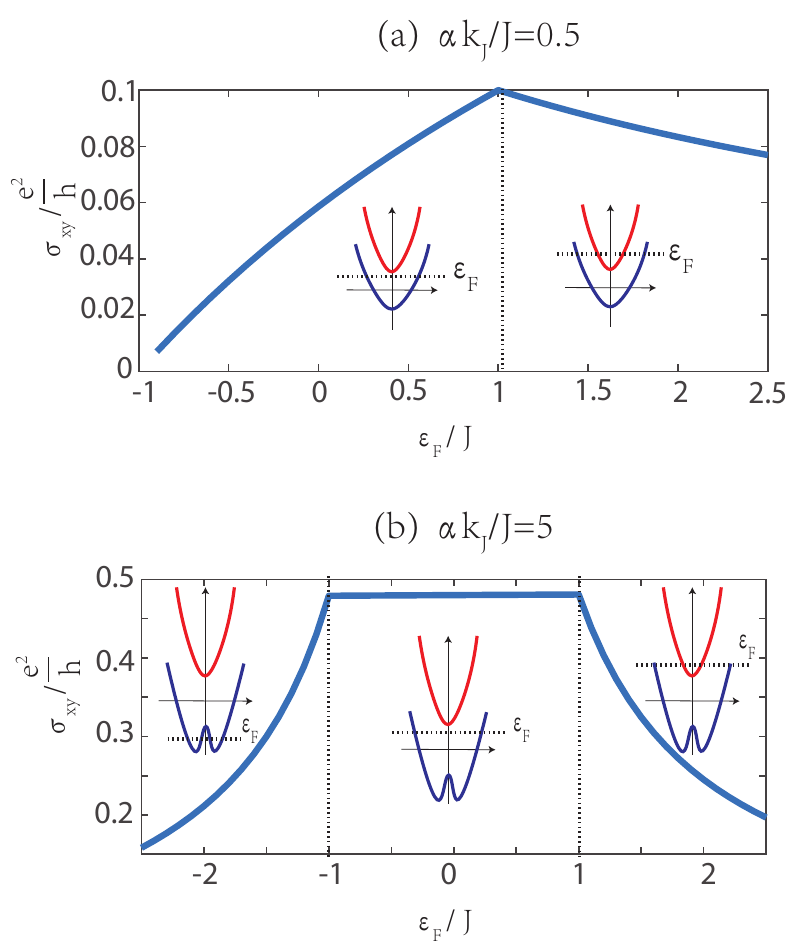
Figure 3. Transverse conductivity σ xy vs. the Fermi energy (cid:101) F , where ( a ) α k J / J = 0.5 and ( b ) α k J / J = 5, the red line and blue line are bandstructures of (cid:101) ↑ and (cid:101) ↓